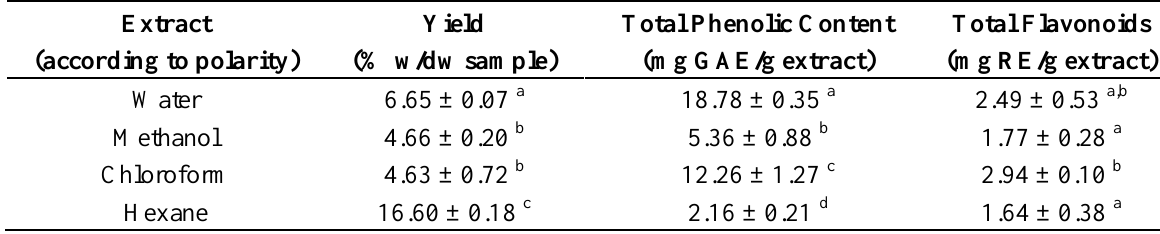
Note: Data are expressed as mean ± SD; Values with different superscripts within the same column are significantly ( p < 0.05) different and vice versa